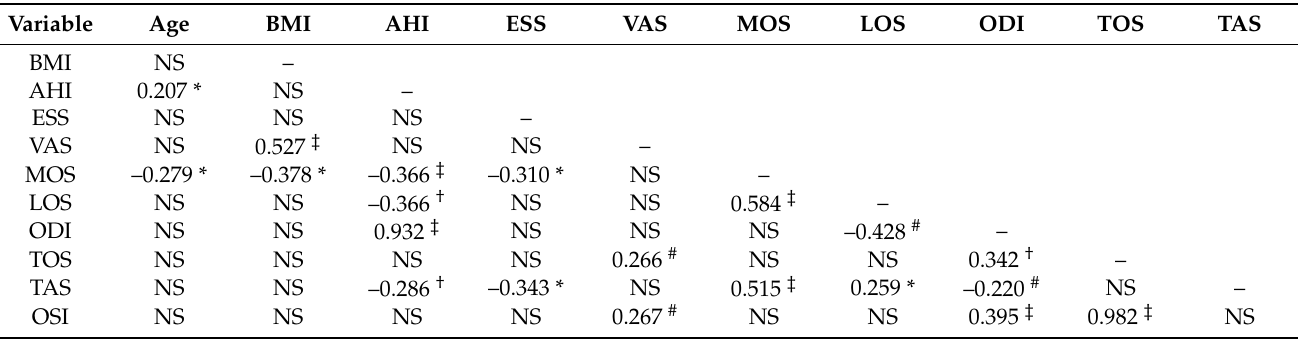
Table 6. Mutual dependences between the investigated parameters.